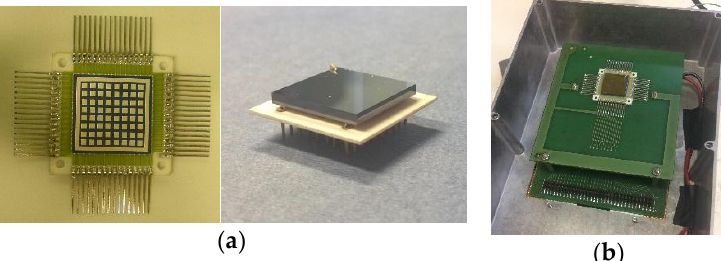
Figure 10. ( a ) The different bonding board of the top (left) and of the bottom CdTe pixel sensor (right) sensor of the Compton-PolCA detection system; and, ( b ) Picture of the detection system. Each PCB supports one of the detectors that are aligned in XY directions. The distance between the two detectors planes can be adjusted between 5 to 20 mm.